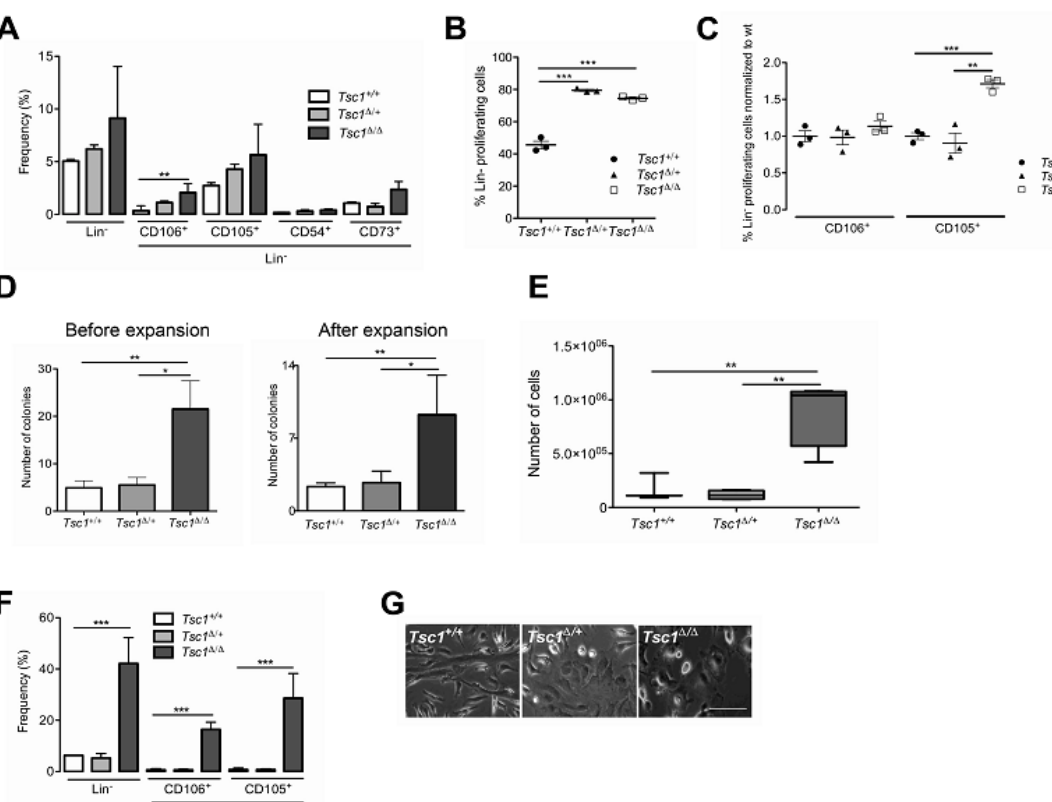
Figure 2. Tsc1 inactivation targets bone marrow mesenchymal stem cells (BM-MSCs) and leads to enhanced proliferation in vivo and in vitro. ( A ) Cell population frequency, determined by flow cytometry of Tsc1 +/+ , Tsc1 ∆ /+ , and Tsc1 ∆ / ∆ BM-Lin - cells immediately following isolation from 28 day old mice, showing Lin - and Lin - CD106, -CD105, -CD54, and -CD73 subpopulations. ( B ) Frequency of proliferating BM-Lin - cells, determined by BrdU incorporation, in control and Tsc1 mutant mice. ( C ) Percentage of proliferative cells within CD106 + and CD105 + subpopulations of BM-Lin - cells. ( D ) CFU-F assay determining colony forming potentials of BM-MSCs from each genotype. Assays were performed by directly plating primary BM Lin - cell isolates (Before expansion) or replating expanded MSCs after 20 days in culture (After expansion). ( E ) The number of adherent cells following in vitro expansion after 20 days. ( F ) Frequency of Lin - , Lin - CD105 + , and Lin - CD106 + cells after 20 days of in vitro expansion.) ( G ) Representative bright-field images of adherent cells from each genotype after 13 days in culture. Panels A–C: Data shown are means ± SD, n = 3 mice per group. Scale bar: 100 µ m. Panels D–F: Data are triplicate measurements of pooled BM-MSCs from each genotype *, p < 0.05; **, p < 0.01; ***, p < 0.001.